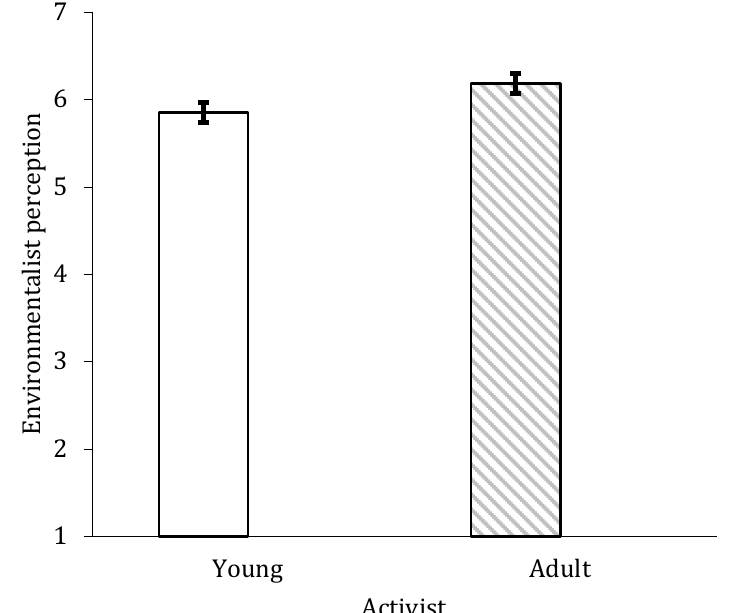
Figure 6. Means and standard errors regarding perceptions of the personalities as environmentalist by experimental conditions.